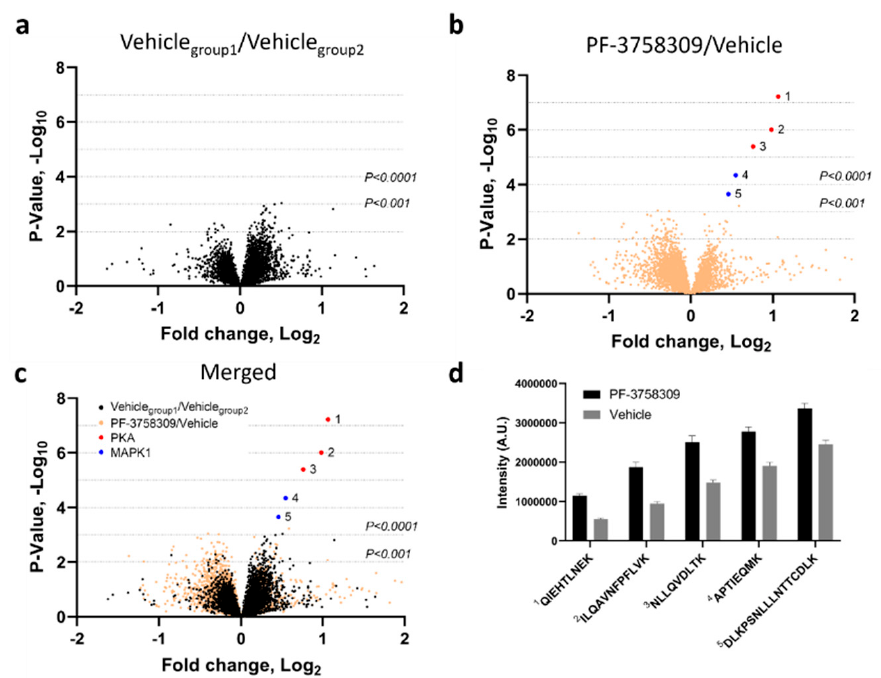
Figure 6. Drug/protein binding analysis of PF-3758309-treated 24ST1NLESG cells. Volcano plots for ( a ) two identical vehicle groups (decoy comparison), ( b ) PF-3758309 and vehicle groups (experimental comparison), and ( c ) the decoy and experimental comparisons merged. The x-axis indicates the relative fold change (log 2 -transformed expression values of peptides in the absence or presence of PF-3758309) and the y-axis indicates the –log10 of the p values. ( d ) Bar graph illustrating enrichment of PKA and MAPK1 peptides in 24ST1NLESG cell lysates treated with PF-3758309. Bar graph data are shown as the mean ± standard